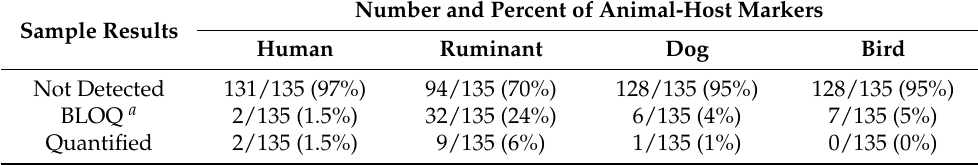
Table 3. Summary of animal–host microbial source tracking marker concentration measurements in samples collected at all sites combined for the 8-week